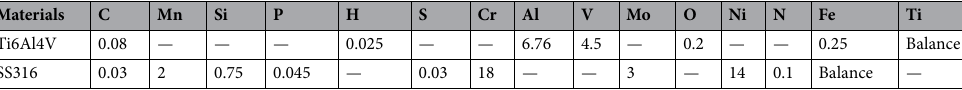
Table 1. Chemical composition of the target materials (wt%).